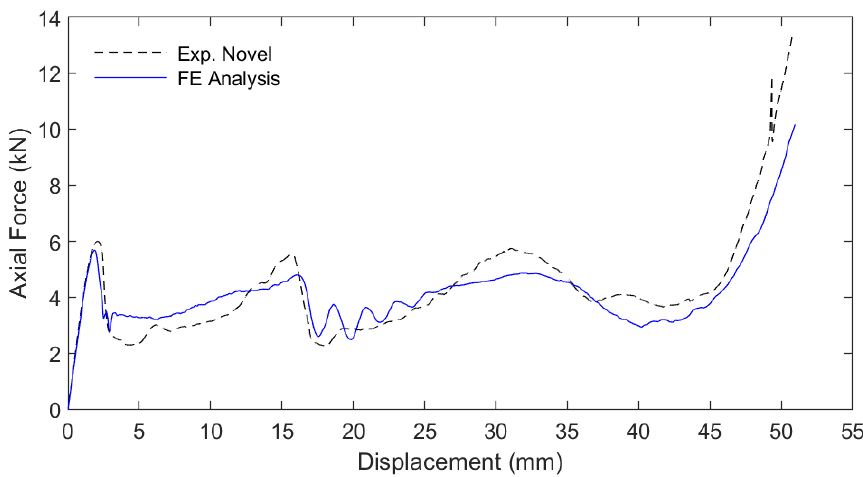
Figure 10. Load vs. displacement curves for novel cell under axial load: comparison between exper- imental and FEA.